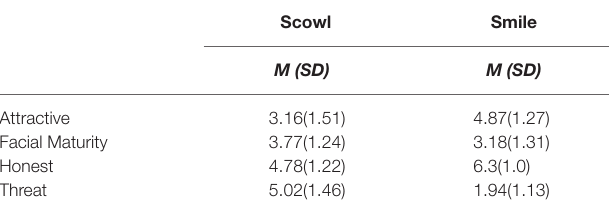
TABLE 3 | Overall comparison of social perception inferences made to smiling and scowling faces, M ( SD ).